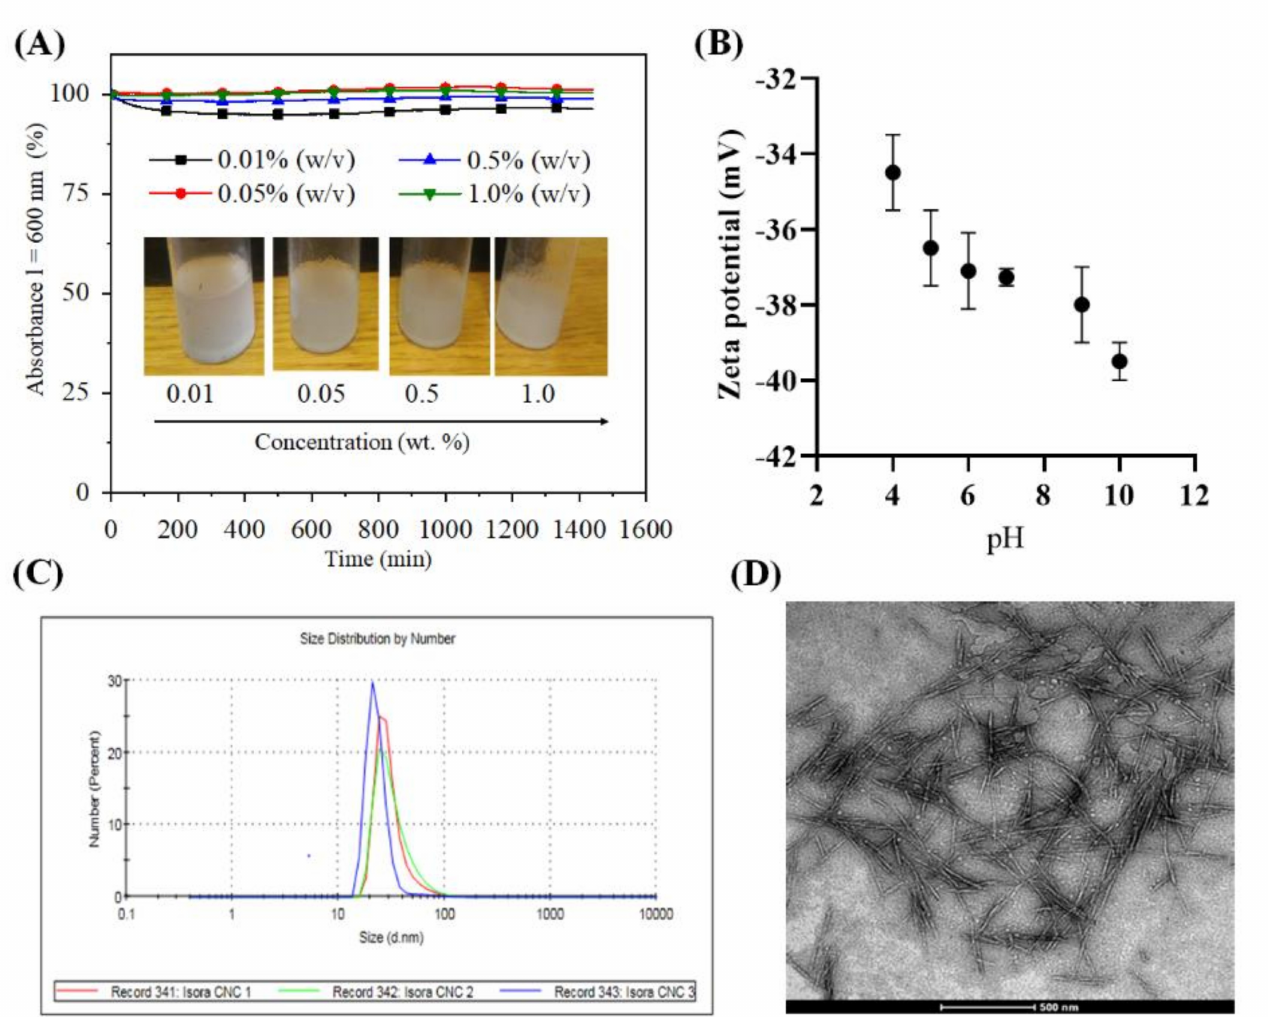
Figure 1. ( A ). Absorbance of Cellulose nanocrystals (CNCs) dispersed in ultrapure water at different concentrations, ( B ) zetapotential, ( C ) particle size distribution (CNC 1: 0 day, CNC2: 1 week, CNC 3: 3 week) and ( D ) Transmission electron microscopy (TEM) image of 0.05 % (w/v) CNCs dispersed in ultrapure